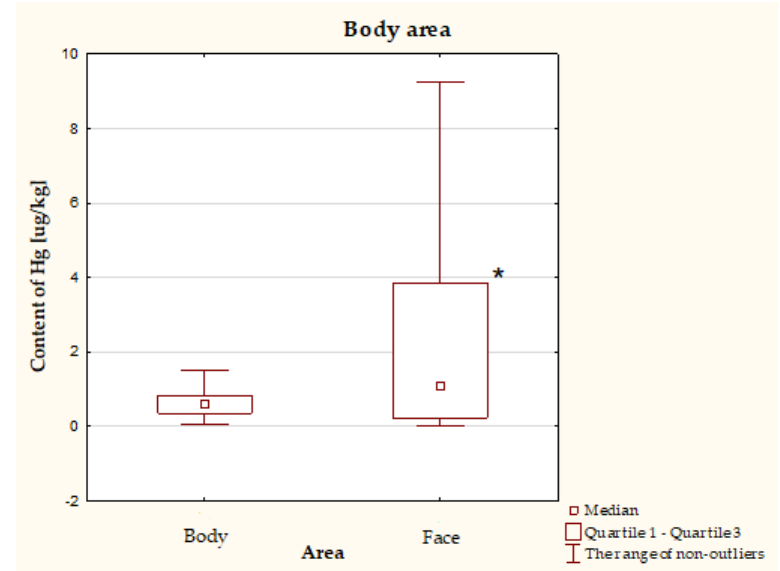
Figure 1. Hg concentration in body ( n = 134) and face ( n = 134) cosmetics. * p < 0.05.